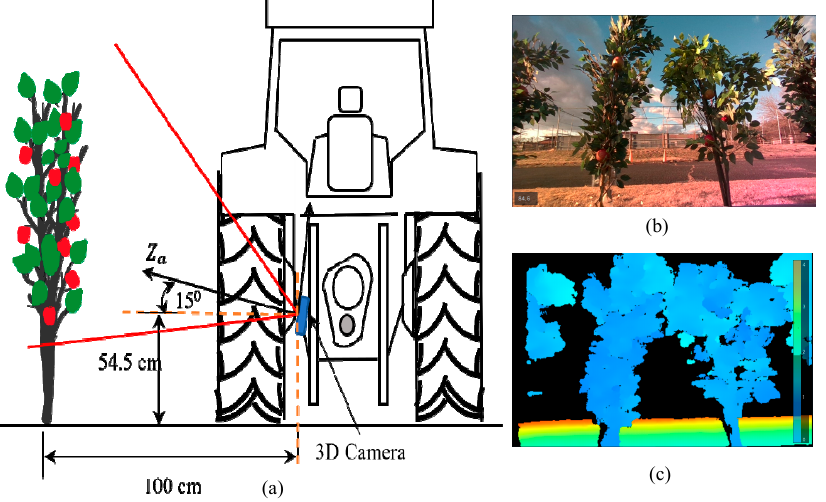
Figure 10. ( a ) A 3D camera at 15 ◦ orientation, ( b ) RGB stream corresponding to the 15 ◦ orientation, and ( c ) a depth stream.